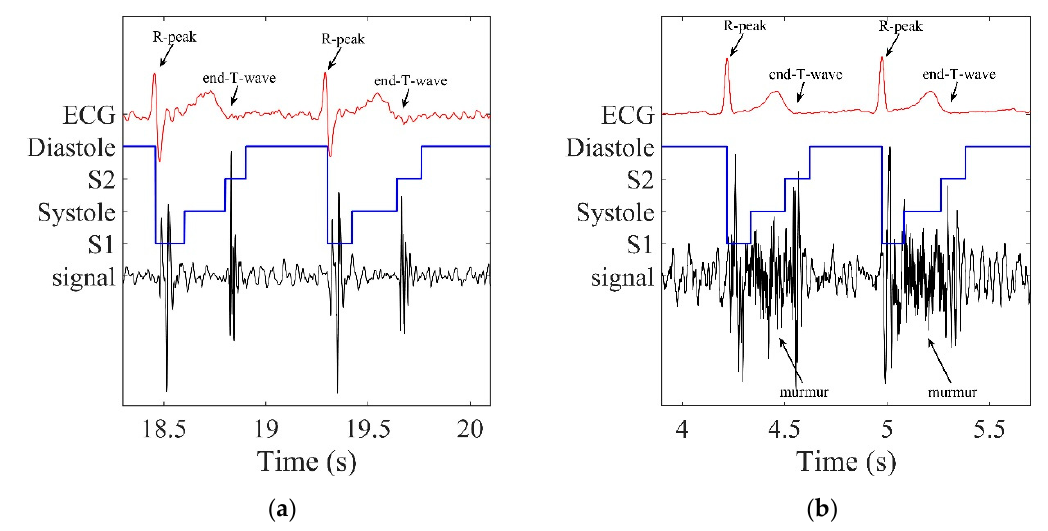
Figure 1. Heart sounds with synchronous electrocardiogram and segmentation results for four states of the heart cycle (S1, systole, S2, and diastole): ( a ) normal heart sound ( b ) abnormal heart sound with heart murmur.